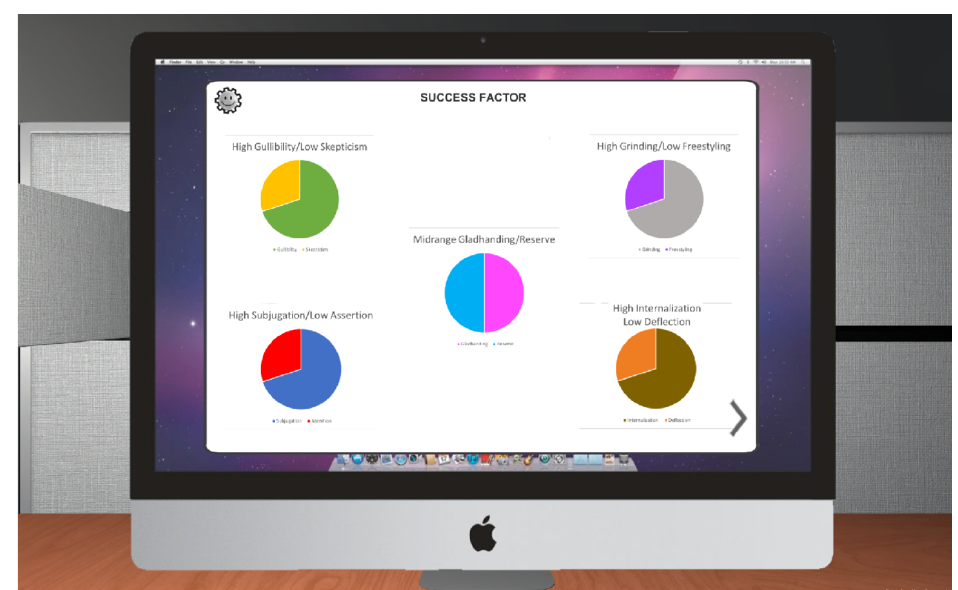
Figure 9. Still from Psychasthenia 3: Dupes . Courtesy of the